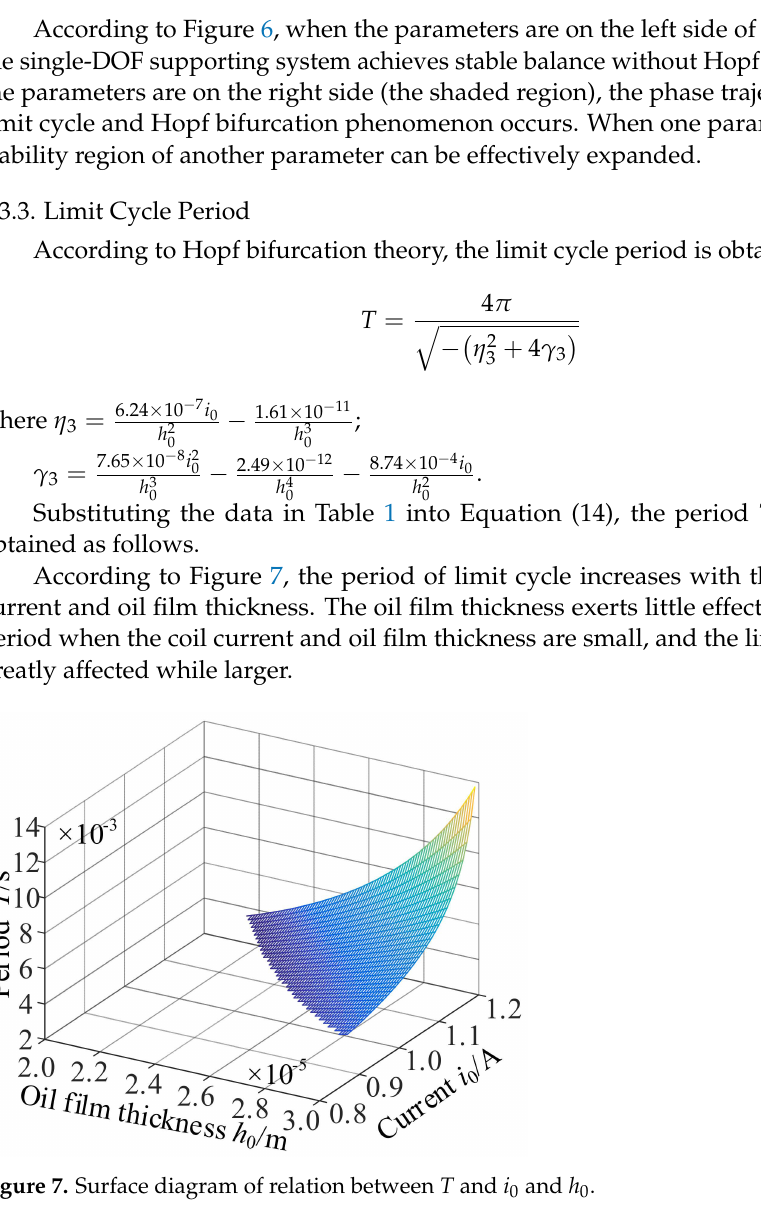
Figure 6. Bifurcation region.